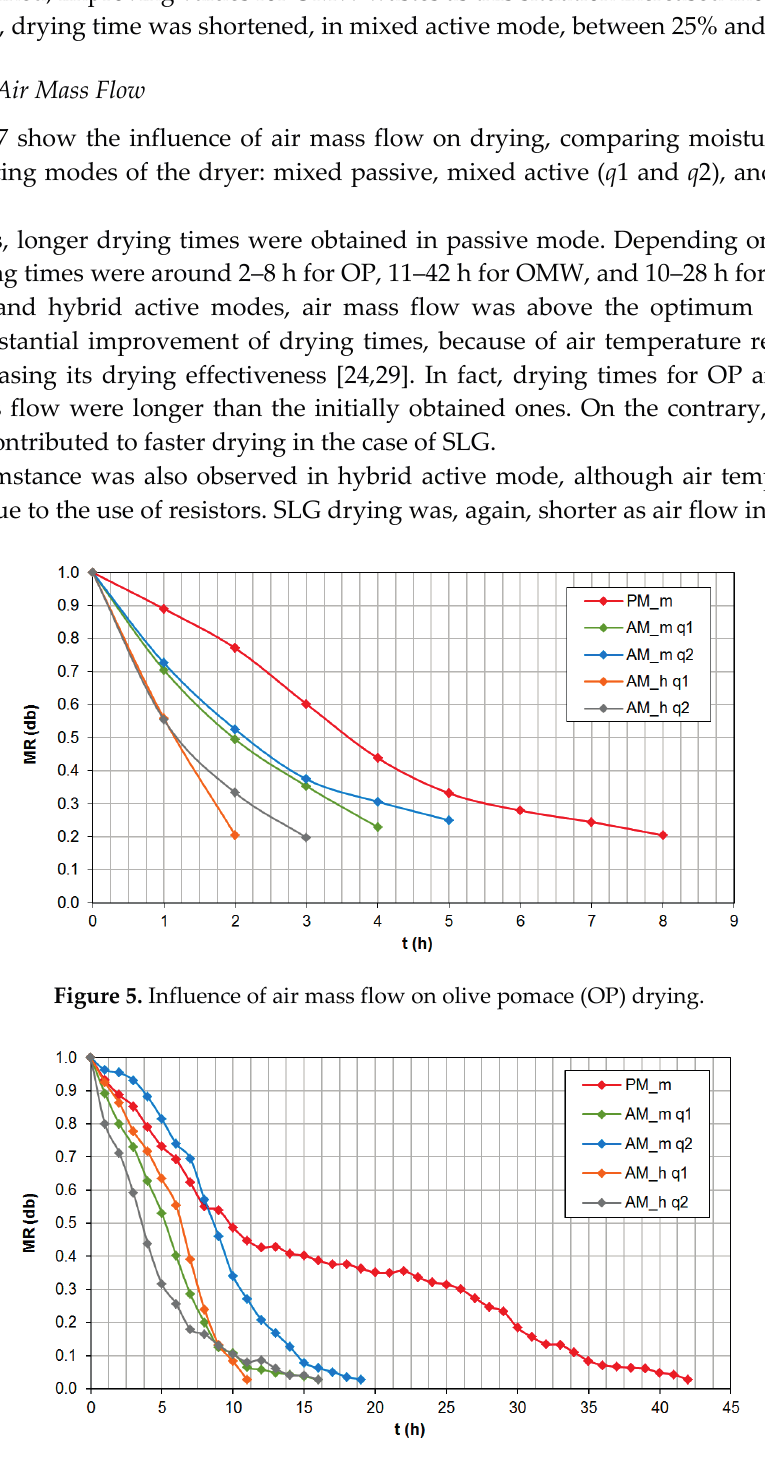
Figure 6. Influence of air mass flow on olive mill wastewater (OMW)